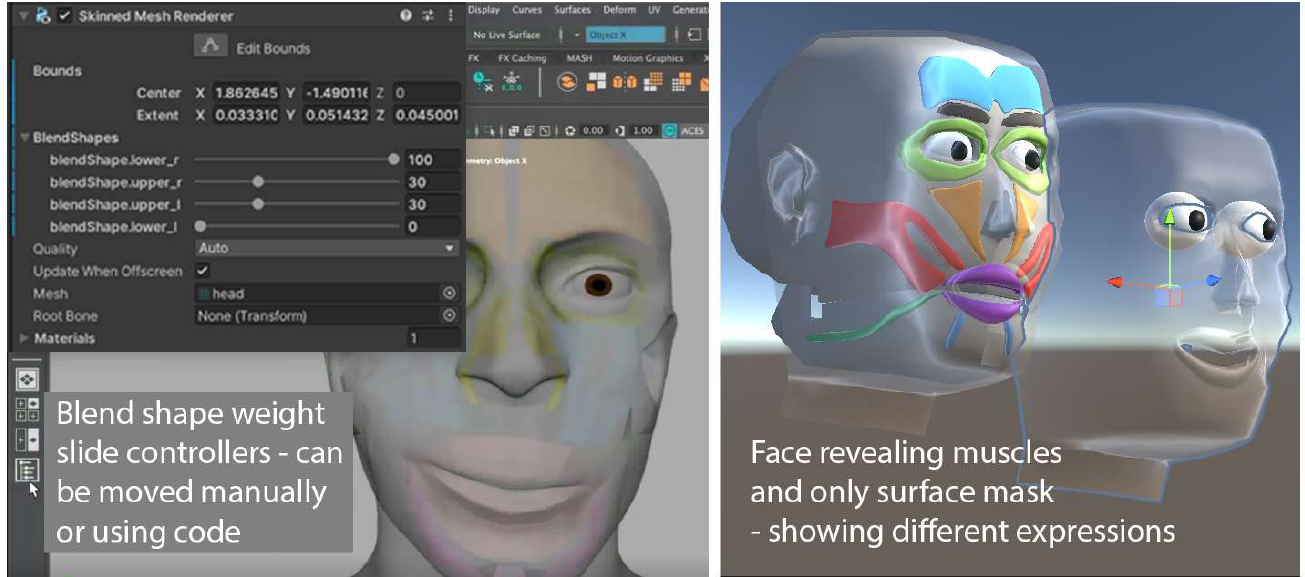
Figure 6. Blend animations on avatar heads by Mateusz Jarzembinski and Nate Durant.